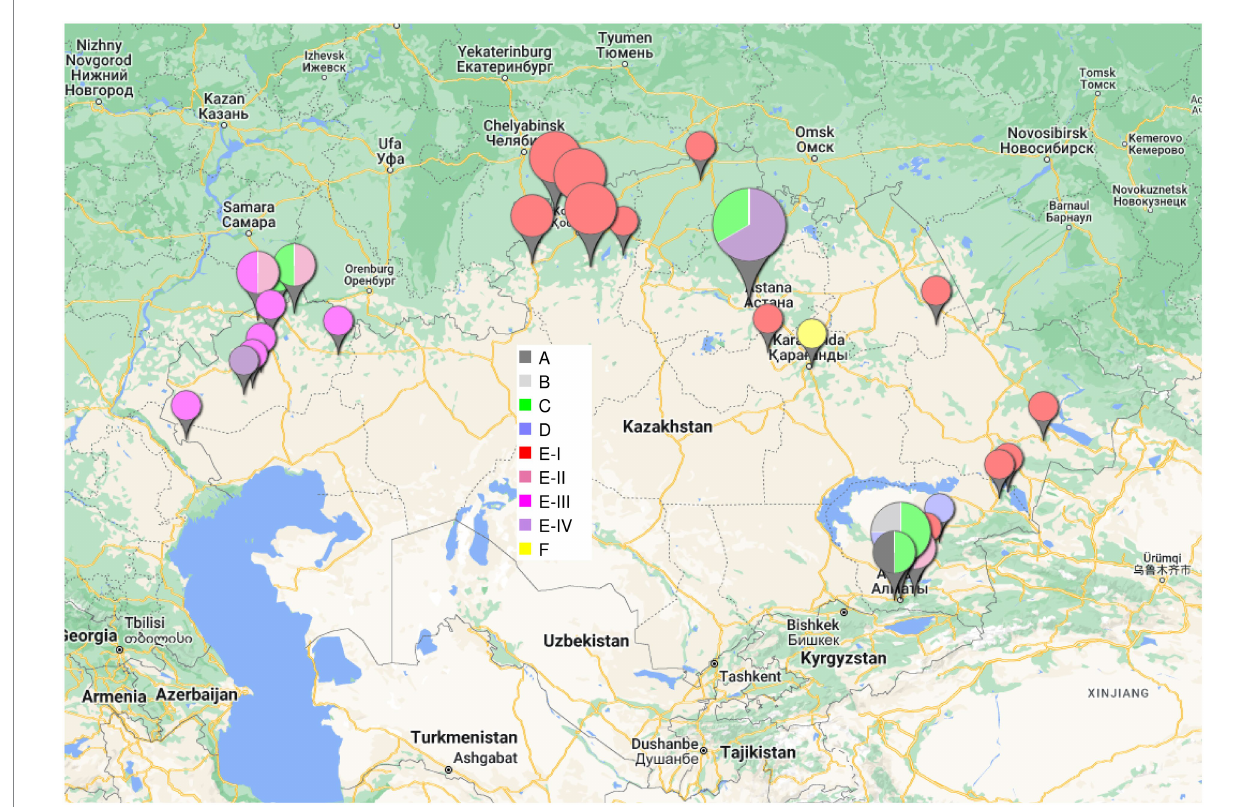
FIGURE 2 Geographic origin of the B. abortus clade C1 strains from Kazakhstan. The size of the labels reflect the number of strains (from 1 to 10) in the corresponding location. The color code shown in the central inset reflects the phylogenetic position (branch assignment) indicated in Figures 1,